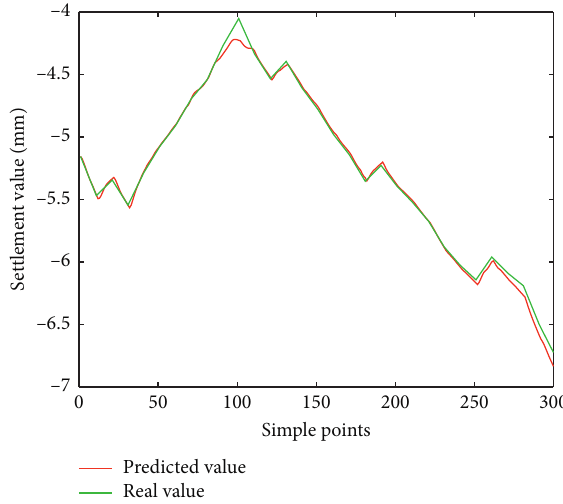
Figure 11: EMD-SVR-WNN prediction